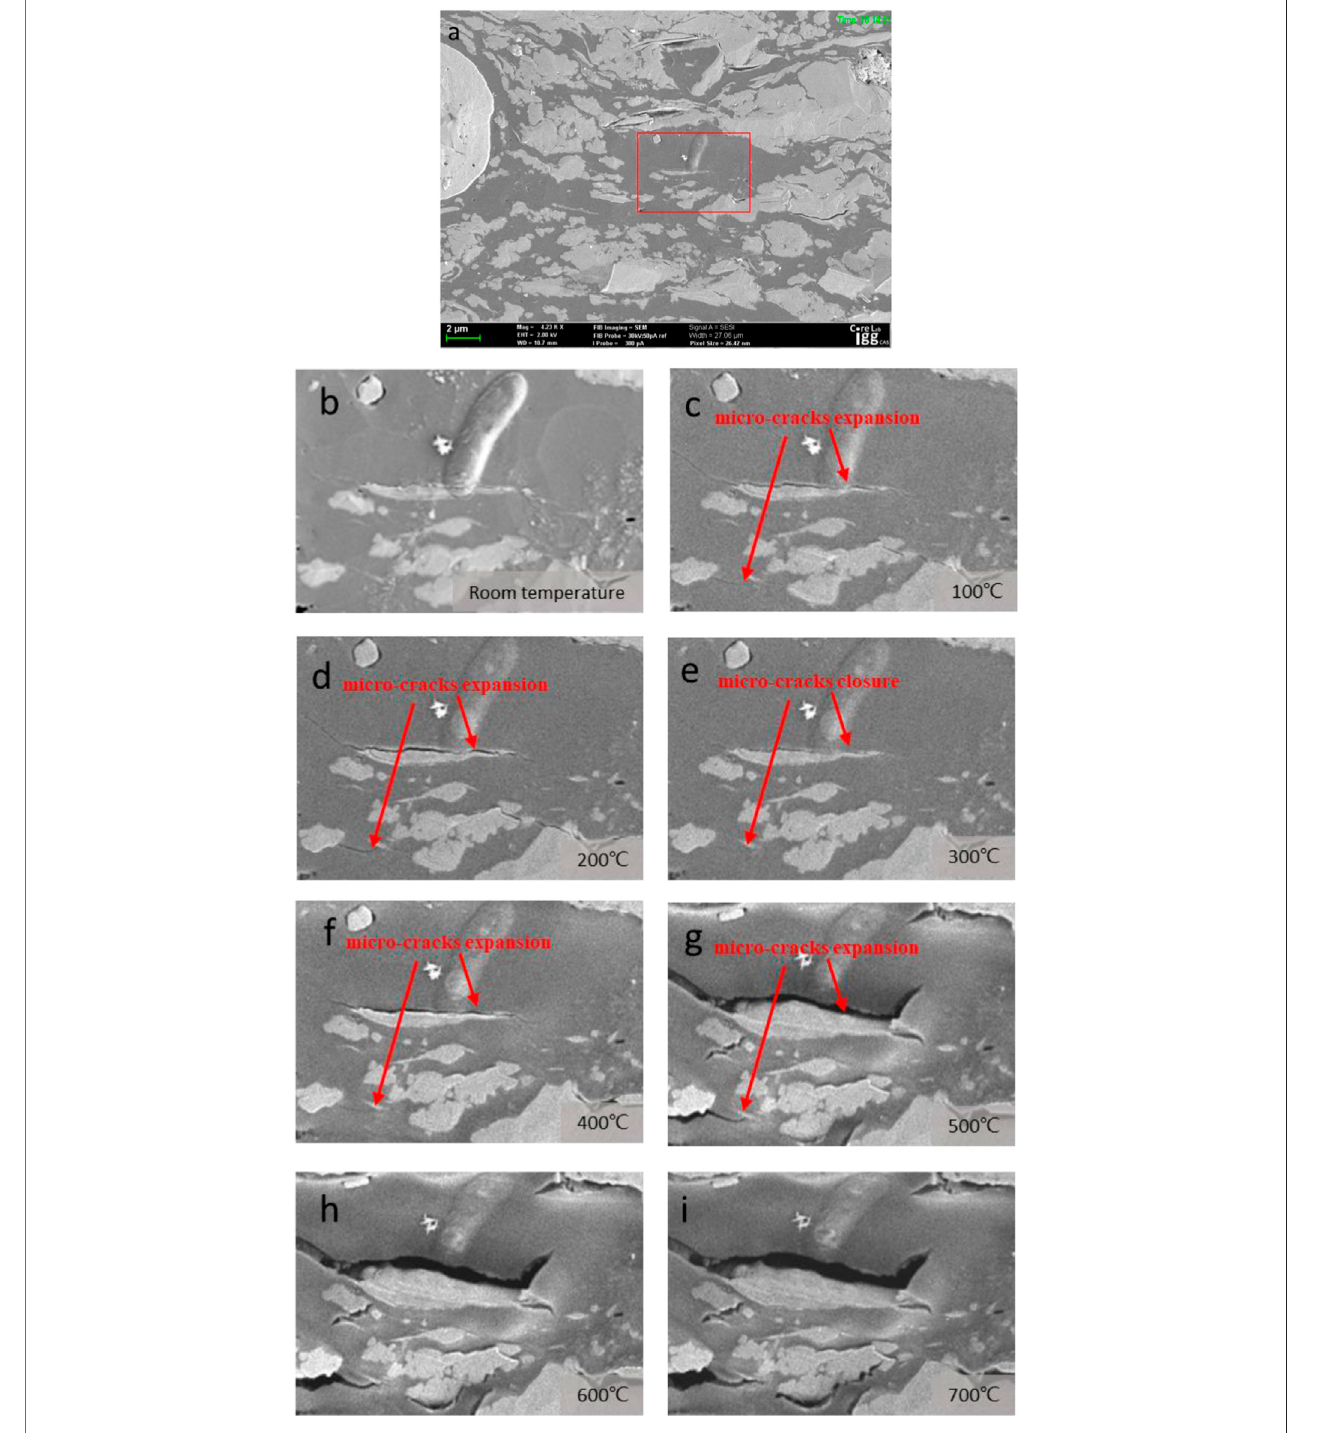
FIGURE 7 | The expansion - closure-expansion phenomenon exhibited by micro-cracks in the sample with temperature changes. Images show regions in which micro-cracks (A) occurred, (B-D) expanded continuously, (D,E) closed, and (E-I) continuously expanded again.